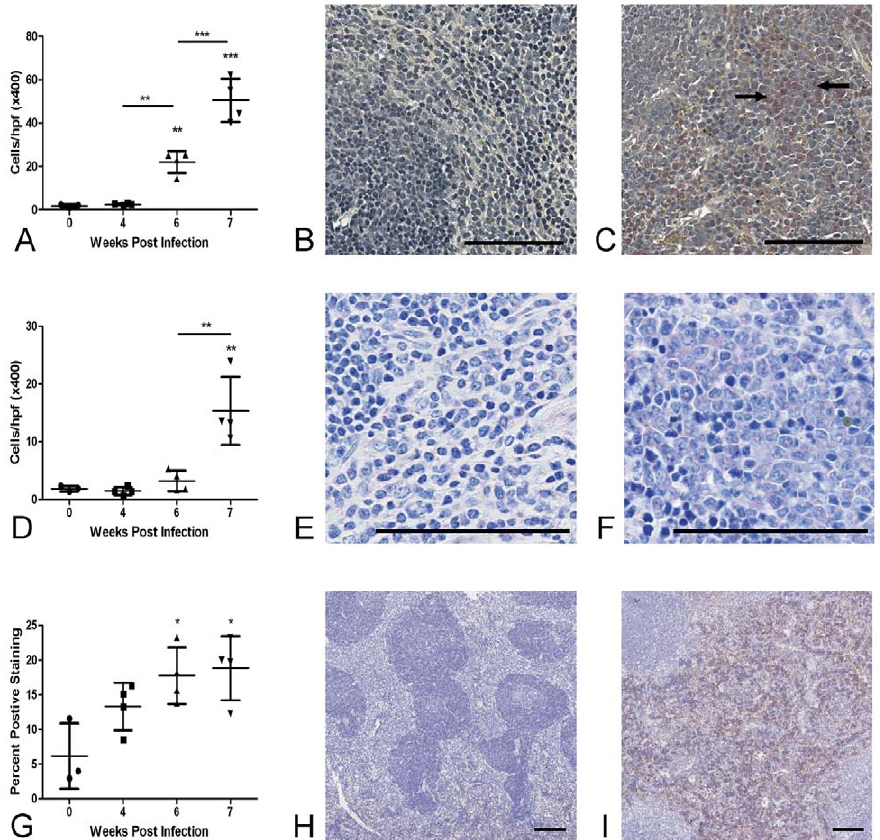
Figure 2. Splenomegaly is associated with accumulation of neutrophils, eosinophils and F4/80 + macrophages in the red pulp. There was a significant increases in the number of neutrophils (A–C: Leder stain for neutrophils (pink stain, arrowed) 6 200 in uninfected control mice (B) and at 7 weeks p.i. (C)), eosinophils (D–F, Giemsa stain 6 400 in uninfected control mice (E) and at 7 weeks p.i. (F)) and F4/80 + macrophages (G–I: F4/ 80 staining in uninfected control mice (H) and at 7 weeks p.i (I). (red-brown) 6 40) in the splenic red pulp from as early as 6 weeks p.i. Values represent mean cells/high power field (eosinophils and neutrophils) or percent positive staining (F4/80) 6 1SD of mice pooled for microarray analysis (n=4 per group). Bar=100 m